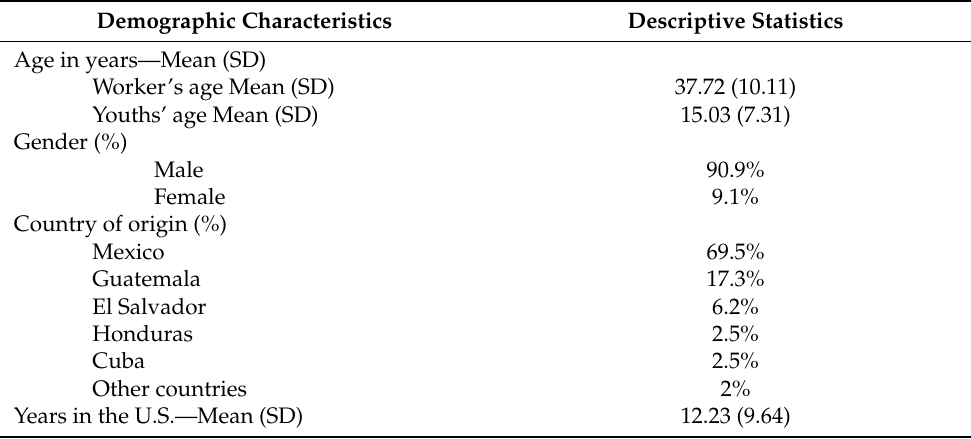
Table 1. Demographic characteristics of the sample ( N = 242).